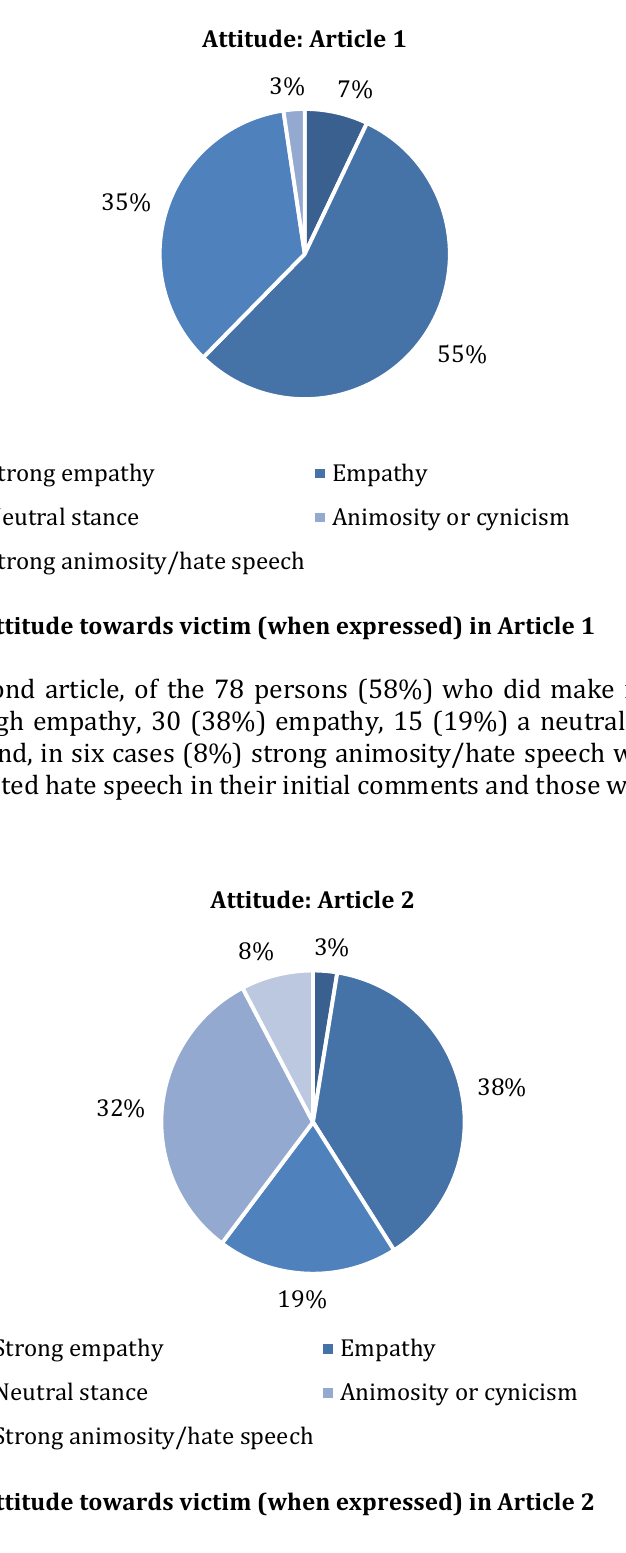
Figure 4: Attitude towards victim (when expressed) in Article 2